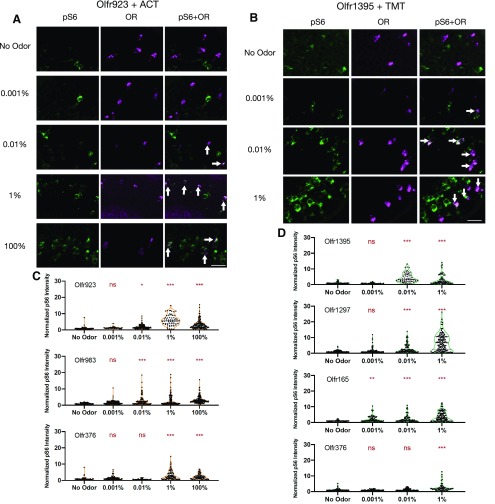
pS6-IP-Seq enrichment data were verified via staining. A, B, Fluorescence microscopy images showing double-label in situ of Olfr923 and Olfr1395 OSNs. Green is antibody staining for pS6, magenta is the DIG probe signal. Colocalizations are marked by white arrows, representing odorant activated OSNs. Scale bar: 25 μm. C, D, Violin plots showing the normalized pS6 intensity for DIG-labeled OSNs based on colocalization, each dot represents a probe labeled OSN. Orange and green colors outline ACT and TMT violin plots, respectively. Quantification of the staining data reveals significant difference in normalized pS6 intensity as a result of odorant stimulation; ns, not significant; *p < 0.05, **p < 0.01, ***p < 0.001 by one-way ANOVA, Dunnett’s post hoc test (various odorant concentrations are compared with no odor controls) for each probe. N = 1–3 mice. See Extended Data Figures 3-1, 3-2 for additional colocalization images and violin plots for ACT responsive ORs. See Extended Data Figures 3-3, 3-4 for lists of pS6-IP-Seq-enriched ORs supporting this figure.